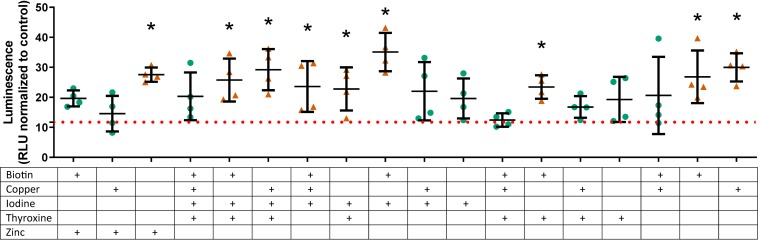
Type II collagen promoter-driven expression with various vitamin and mineral combinations in the presence of TGFβ1 on day 21. Vitamins and minerals (biotin, copper, iodine, thyroxine, and zinc) which had been identified as promoting COL2A1 promoter-driven expression in the initial screen were tested in combination at their individually optimized concentrations (3, 670, 0.92, 20, and 840 μg/L, respectively) in the presence of TGFβ1 at 1 ng/mL. The values are normalized to the plate control (basal media). Green circles () indicate values that are significantly greater than those for basal media alone, and the dashed red line indicates the luminescence achieved with TGFβ1 supplementation at 1 ng/mL. An orange triangle () and an * indicate values that were discovered different, with false discovery rate set at 1%.